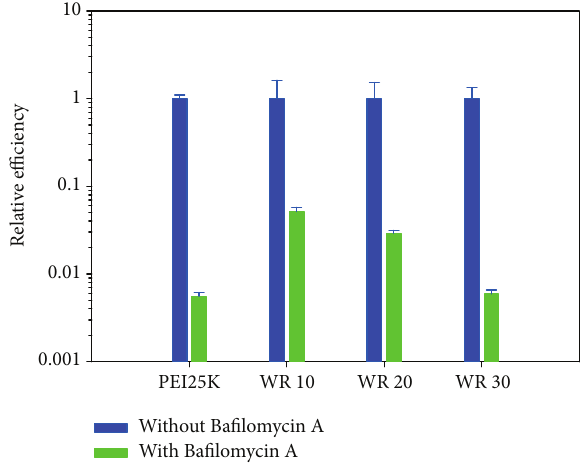
Figure 7: Transfection experiment results with/without Bafilo- mycin A1 in A549 cells. WR means the weight ratios of MPD poly- plexes. Relative efficiency is the ratio of transfection efficiency with Bafilomycin A1 to the transfection efficiency without Bafilomycin